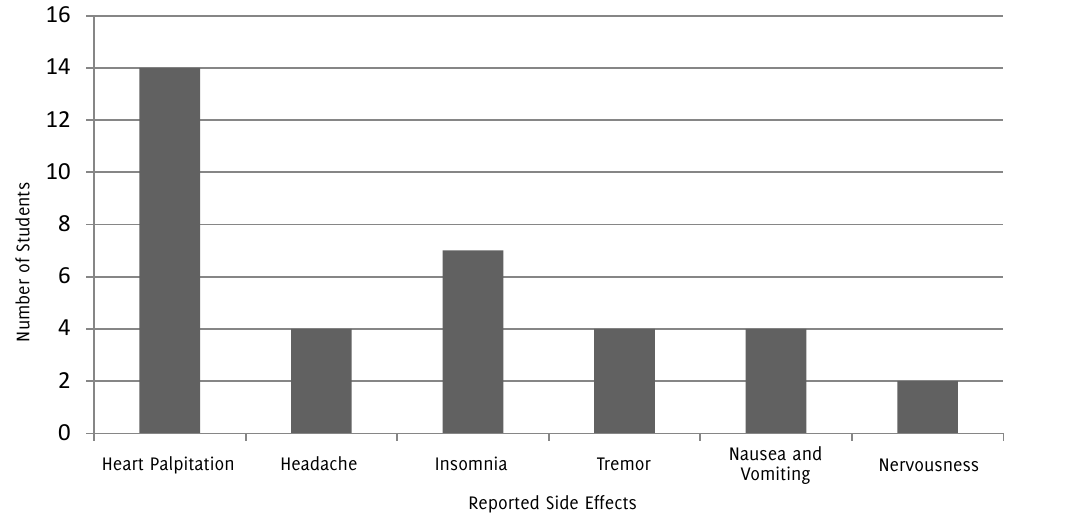
Figure 3. Reported Symptoms of Caffeine Intoxication after Energy Drink Consumption among Medical Students in Clinical